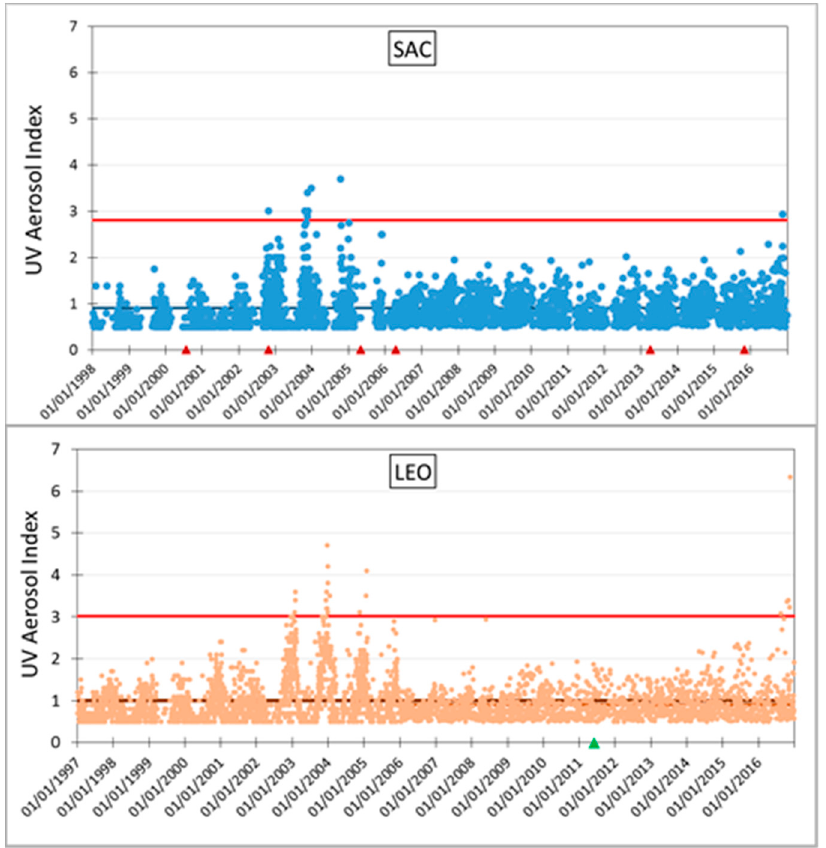
Figure5. ( Top ) UV aerosol index measured by TOMS and OMI instruments on board of different NASA satellites, at the SAC site. The red arrows indicate the days when a significant eruption was produced by the near Lascar volcano; ( Bottom ) similar results for LEO site, with a green arrow indicating the day of large eruption originated in the Puyehue- Cordón Caulle volcanic complex. The horizontal line in the middle of the data indicates the mean value. Goddard Space Flight Center/NASA